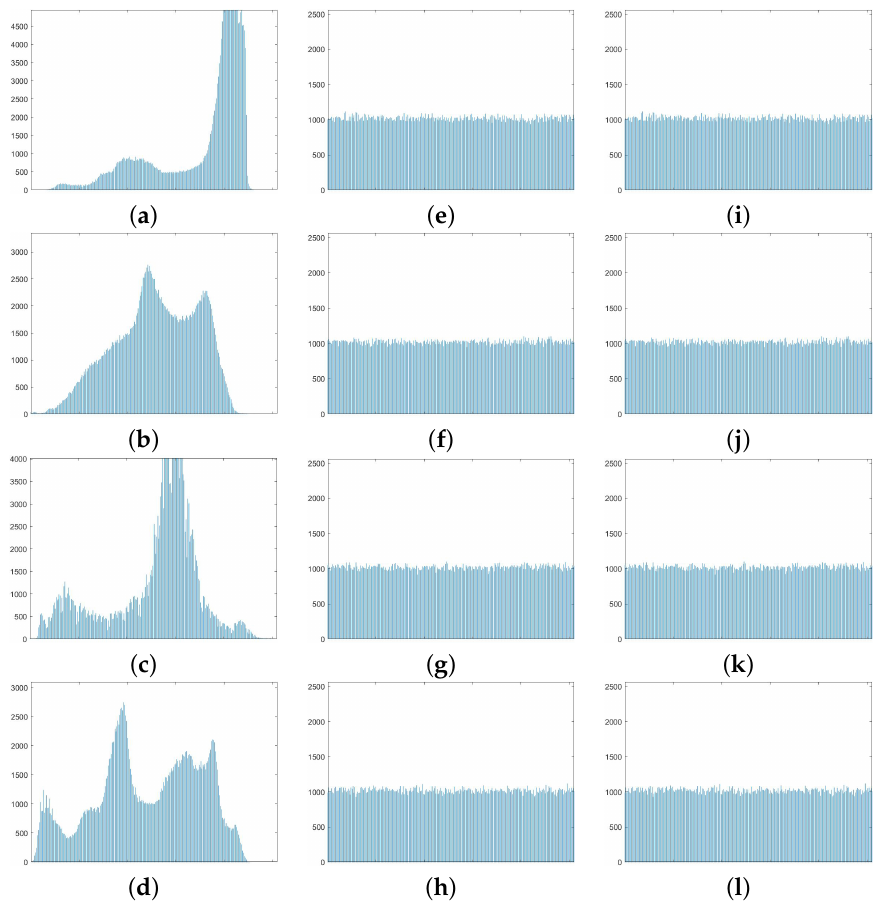
Figure 6. Histogram results of the four images: airplane, baboon, boat and peppers. Figure ( a – d ): Original image histograms, Figure ( e – h ): Encrypted image histograms, Figure ( i – l ): Histograms from the images after hiding the